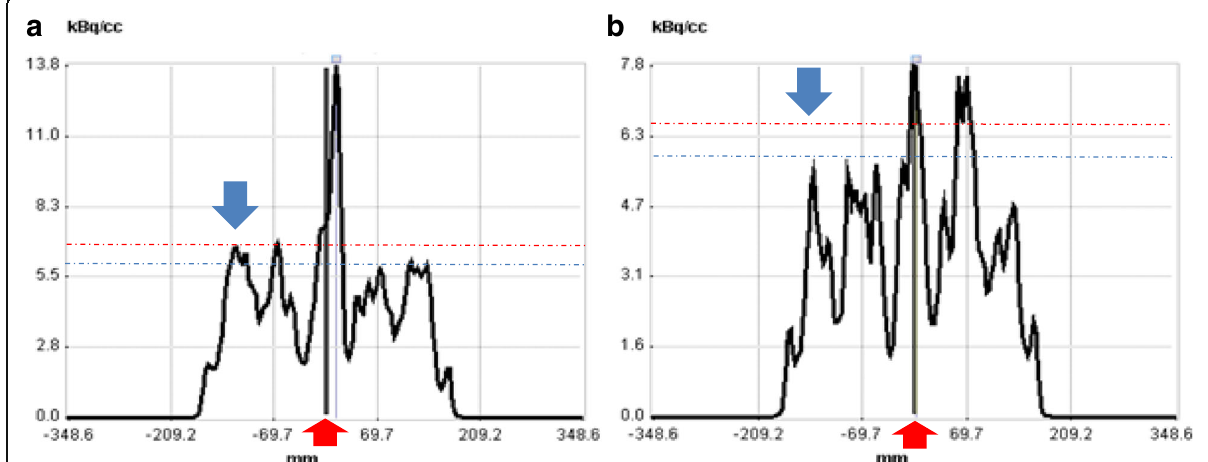
Fig. 8 The line profiles that pass through the tumour and non-tumour activity in a patient scan at 2 h before enema as seen in Fig. 6b (in a ) and at 4 h after enema as in Fig. 6c (in b ). The red arrow shows the non-tumour region, and the blue arrow shows the surrounding region that encompassed the tumour. This figure shows that enema was helpful in reducing the non-tumour activity concentration from 13.8 kBq/cm 3 (in a ) to 7.8 kBq/cm 3 (in B), a decrease of 44%. Consequently, the activity concentration in the surrounding region was also reduced from 7 kBq/cm 3 (in a ) to 6 kBq/cm 3 (in b ), a decrease of 14%. The red and blue dotted lines show the same numeric values on y-axis; h = hour; kBq = kilo Becquerel; CC or cm 3 = cubic centimetre; mm = millimetre; % =